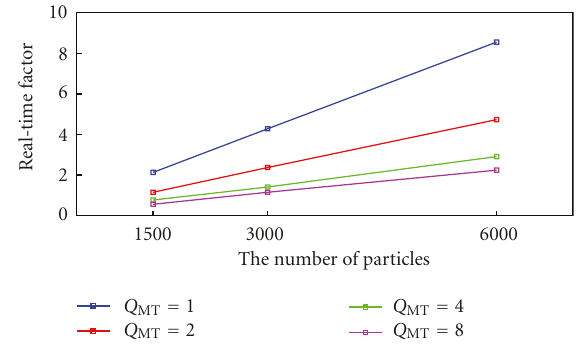
Figure 9: Real-time factor